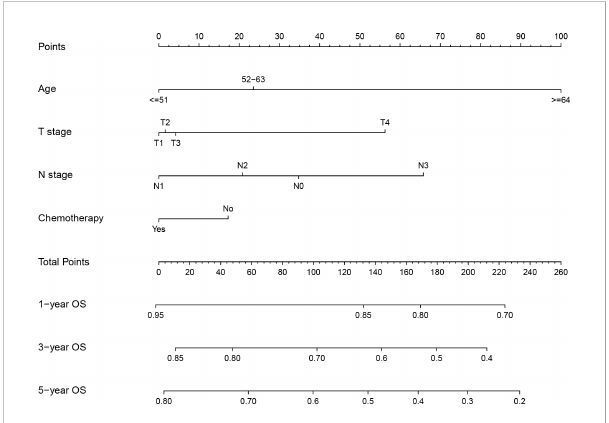
FIGURE 2 Nomogram for prediction of 1-, 3- and 5-year overall survival of locoregionally advanced nasopharyngeal